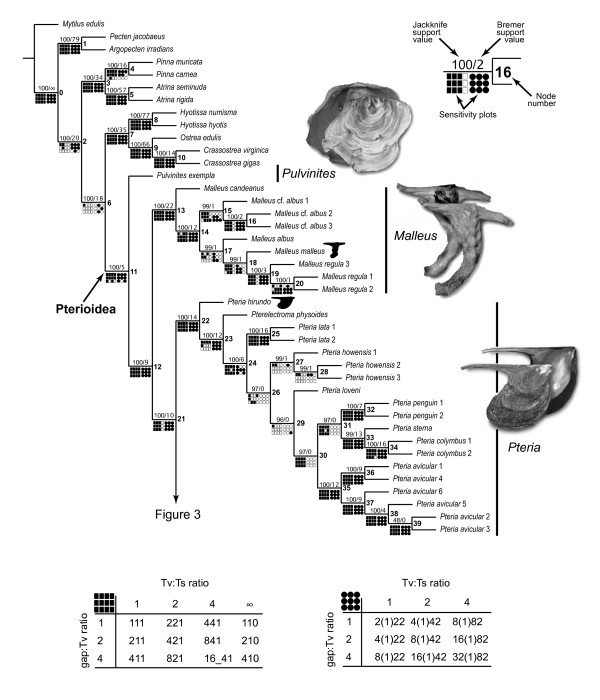
A partial view of the most-parsimonious tree based on the analysis of the complete data set and the results of the sensitivity analysis showing the relationships of the outgroups, and the genera Pulvinites, Malleus, and Pteria. The single most-parsimonious topology (L = 6027, CI = 0.56, RI = 0.86) of the complete data set resulting from the combined analysis of the 18S, 28S, 16S, and H3 data under uniform weighting. Numbers at the nodes denoted node numbers; numbers above the branches indicate jackknife/Bremer support values. The results of the sensitivity analysis are summarized below the branches as binary plots with filled shapes denoting clade presence and open shapes denoting clade absence. Circles and squares indicate whether the analyses were performed with or without taking the affine gap costs into account respectively. The tables below describe specific parameter combination used for each analysis listing the costs in the following order: "indel/transversion/transition" or "gap opening/(gap extension)/transition/transversion." Shell icons denote type species.